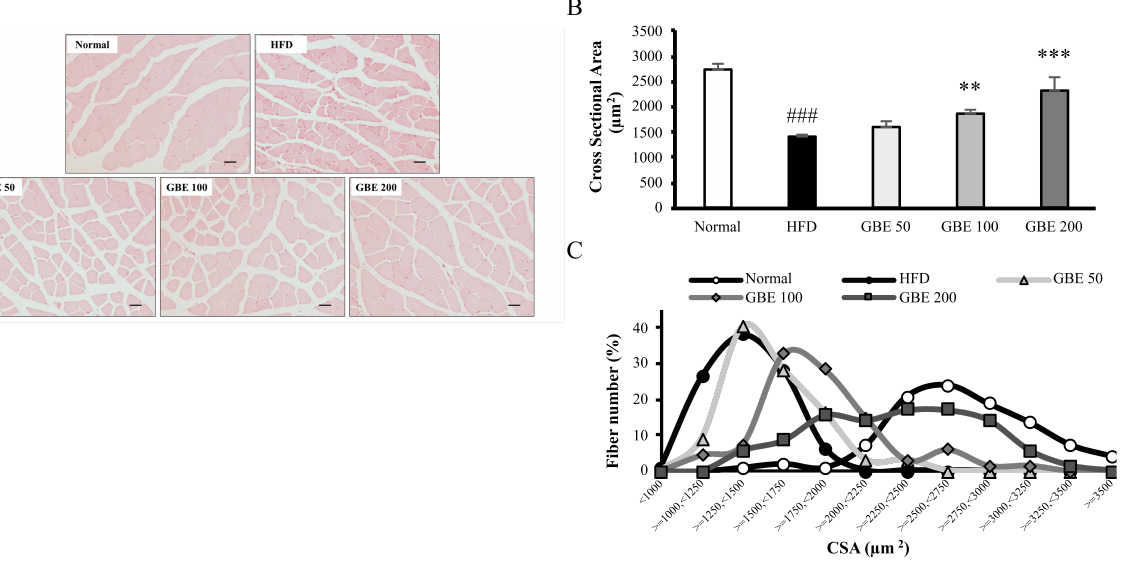
Figure 4. GBE administration significantly decreased significantly increased myofiber cross-sectional area (CSA). ( A ) H&E staining of gastrocnemius. ( B ) The mean adipocyte size of epididymal fat. ( C ) The distribution graph of adipocyte size. Data are expressed as mean ± SD. ### p < 0.001 versus the normal group. ** p < 0.01 and *** p < 0.001 versus the HFD